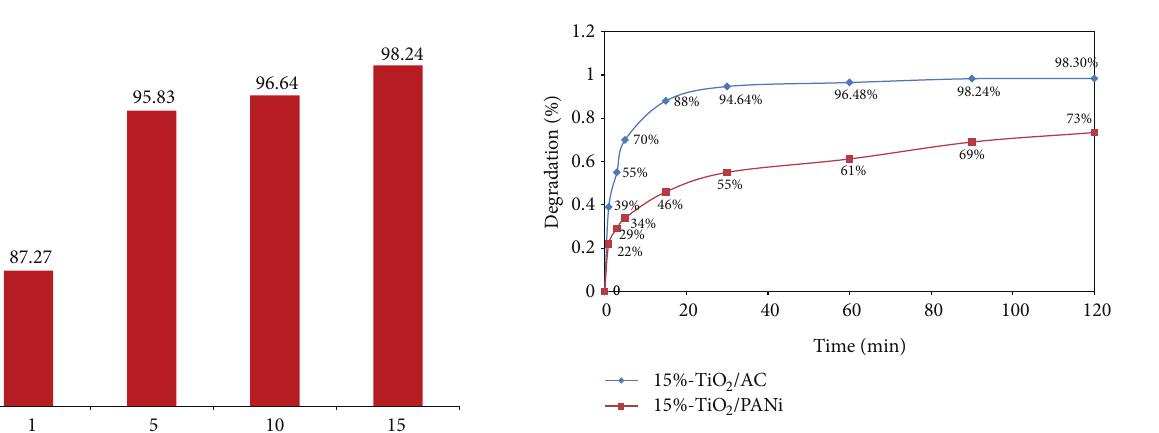
Figure 8: Photocatalytic activity: effect of irradiation time in degradation of MB.